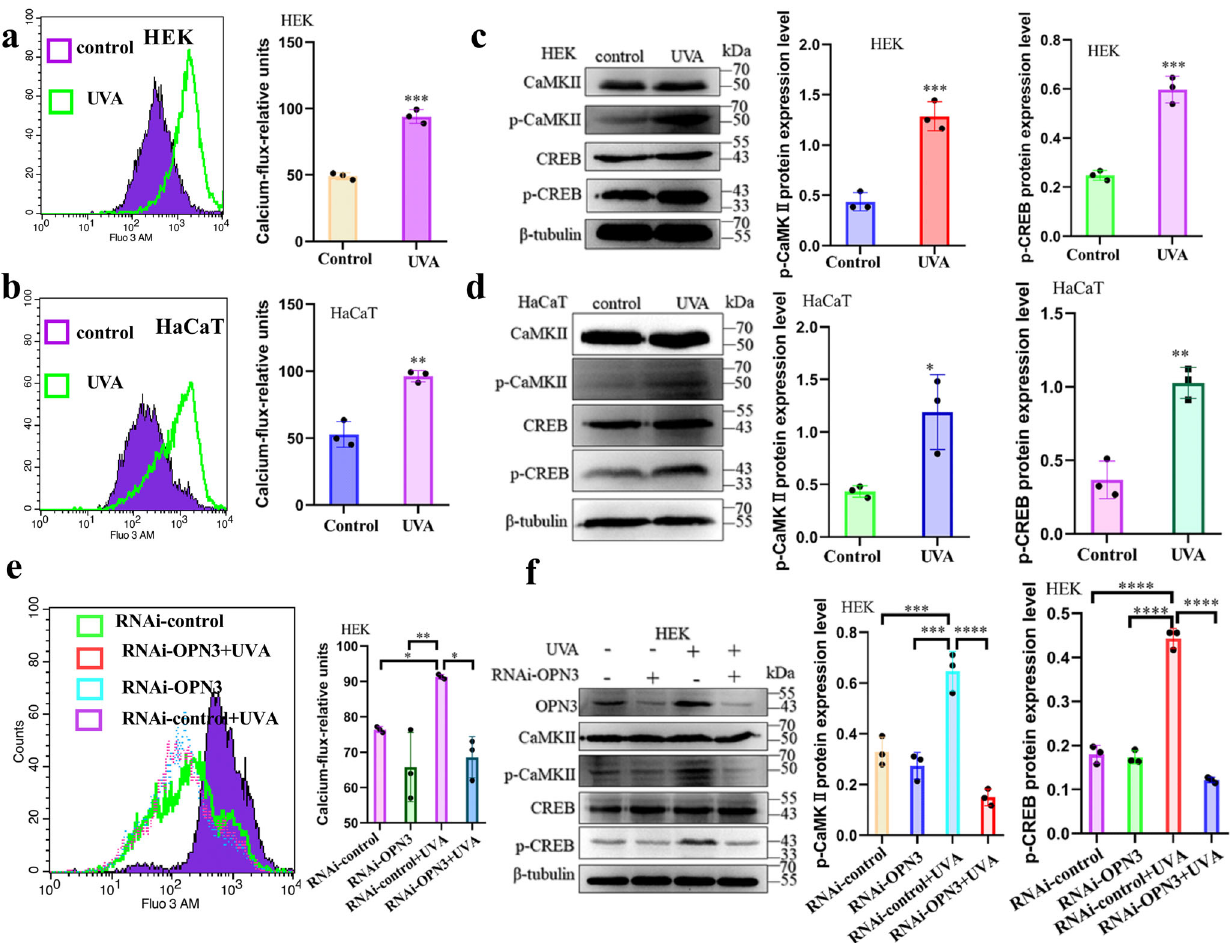
Fig. 5 OPN3 mediates melanin cap formation via the calcium signaling pathway. a , b HEK and HaCaT calcium fl uxes were quanti fi ed by fl ow cytometry. n = 3 independent experiments. Statistical signi fi cance was determined by t -test analysis. ** P < 0.01, *** P < 0.001. c , d Phosphorylated Ca 2 + /calmodulin- dependent protein kinase (CaMK)II and cyclic adenosine monophosphate response element-binding (CREB) protein were analyzed by WB 1 h after irradiation of HEK and HaCaT with 3 J cm − 2 UVA. WB analyses were normalized using β -tubulin as a loading control, and the relative protein level was quanti fi ed using Quantity One software. Statistical signi fi cance was determined by t -test analysis. * P < 0.05, ** P < 0.01, *** P < 0.001. e After siRNA inhibited OPN3 irradiated without or with UVA, calcium fl uxes were quanti fi ed by fl ow cytometry. n = 3 independent experiments. Statistical signi fi cance was determined by one-ANOVA with post-test. * P < 0.05, ** P < 0.01. f After siRNA inhibited OPN3 irradiated without or with UVA, WB was used to analyze changes of OPN3, p-CaMKII, and p-CREB protein expression levels in HEK ( n = 3 independent experiments). WB analyses were normalized using β -tubulin as a loading control, and the relative protein level was quanti fi ed using Quantity One software. Statistical signi fi cance was determined by one- ANOVA with post-test. *** P < 0.001, **** P <